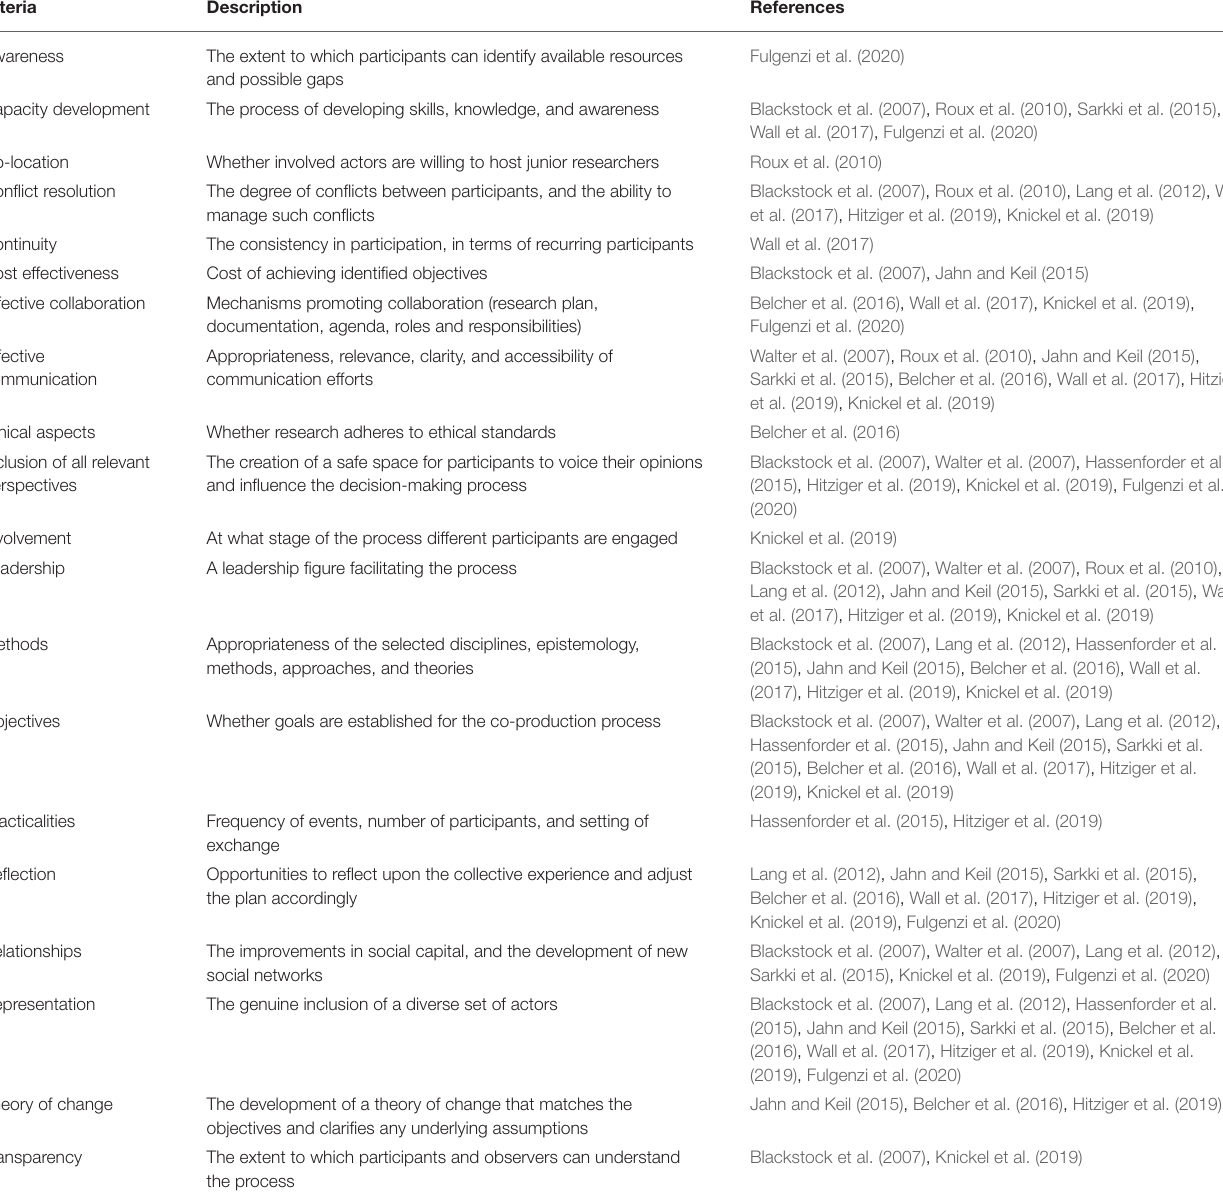
TABLE 3 | Criteria for evaluating co-produced knowledge – the